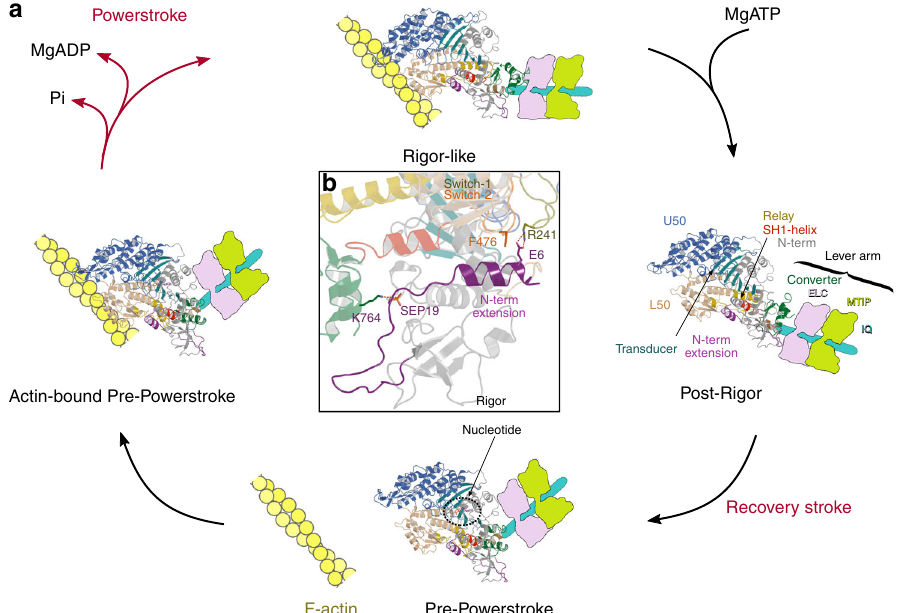
Fig. 2 Structural states and motor cycle of PfMyoA. a The crystallographic structures of the three states of the motor cycle of PfMyoA are represented along the motor cycle: the Rigor-like and the Post-rigor (PR) states reveal how the motor detaches from F-actin upon ATP binding; the Pre-powerstroke (PPS) state corresponds to the state in which hydrolysis occurs and that rebinds to F-actin to trigger the powerstroke. The Rigor-like state is the conformation the motor adopts at the end of the powerstroke when hydrolysis products have been released. To appreciate the movement of the converter and how it can be ampli fi ed by the rest of the lever arm, the IQ region and the two LCs (PfELC and MTIP, Supplementary Fig. 1) are represented schematically in continuity of the last helix of the converter. PfMyoA displays the four canonical subdomains which are the hallmark of the myosin superfamily: N-terminus (N-term) (gray), Upper 50 kDa (U50) (marine blue), Lower 50 kDa (L50) (tint) and the converter (green) and central elements (including a beta-sheet) forming the transducer (dark cyan). During the motor cycle, rearrangements in the motor domain are allosterically transmitted through the Relay helix (yellow) and are ampli fi ed by the swing of the converter with the rest of the lever arm. b In the center diagram, a zoom of the Rigor- like structural state is presented to show the opposite side of the motor domain compared to a . Note the position of the unique N-terminal extension (purple) which is close to the connectors that direct rearrangements between motor subdomains (Switch-2 (orange), Relay (yellow) and SH1-helix (red)). PfMyoA employs an atypical motor mechanism in which the N-term extension (purple) compensates for non-canonical sequences in subdomain connectors essential for motor